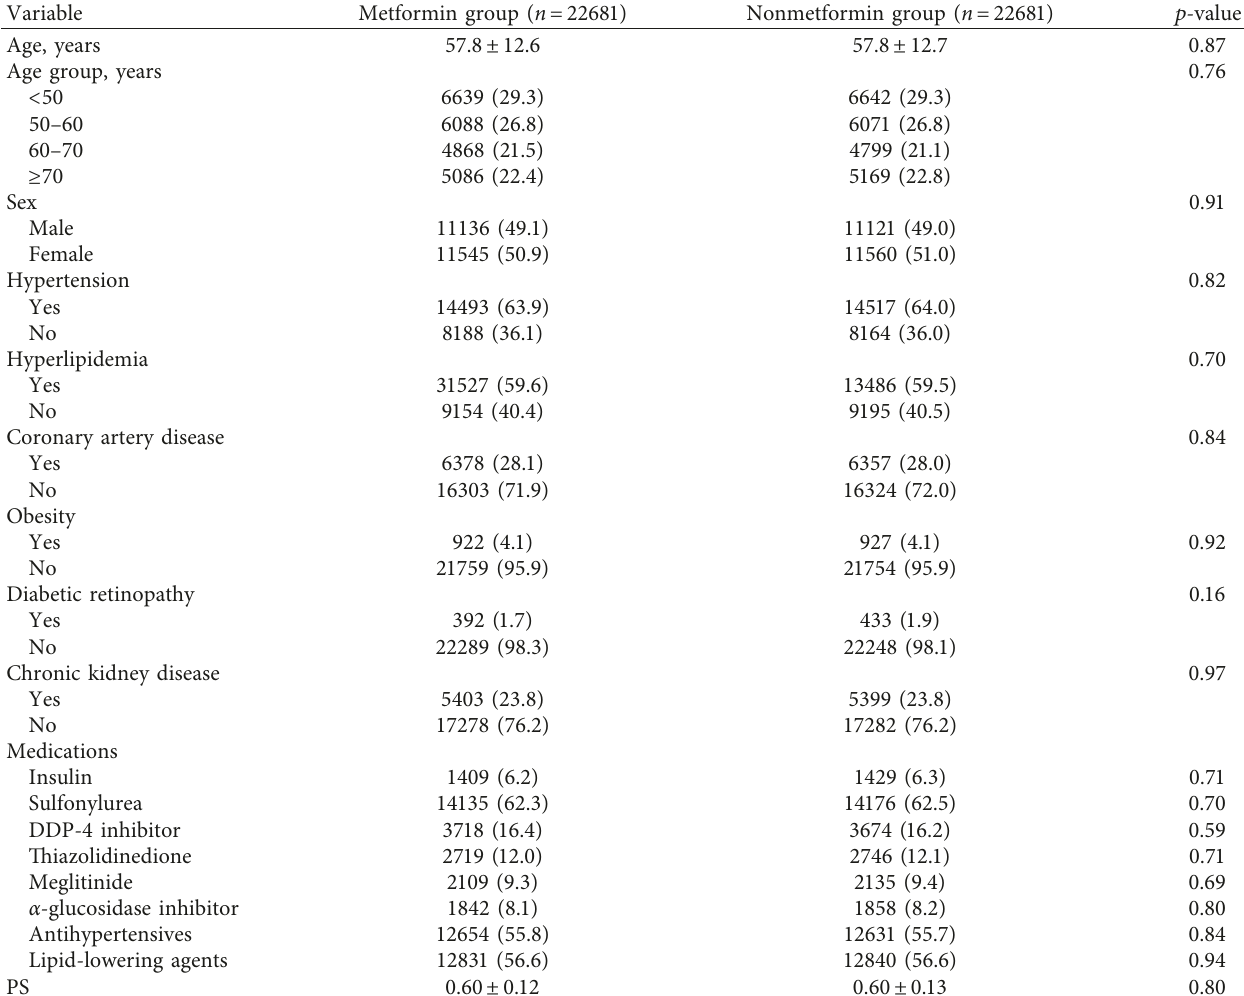
Table 3: Characteristics of the PS-matched sample.